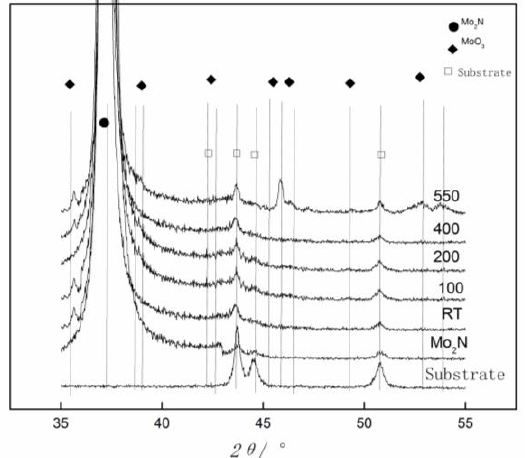
Figure 5. Patterns of wear tracks at different testing temperatures.